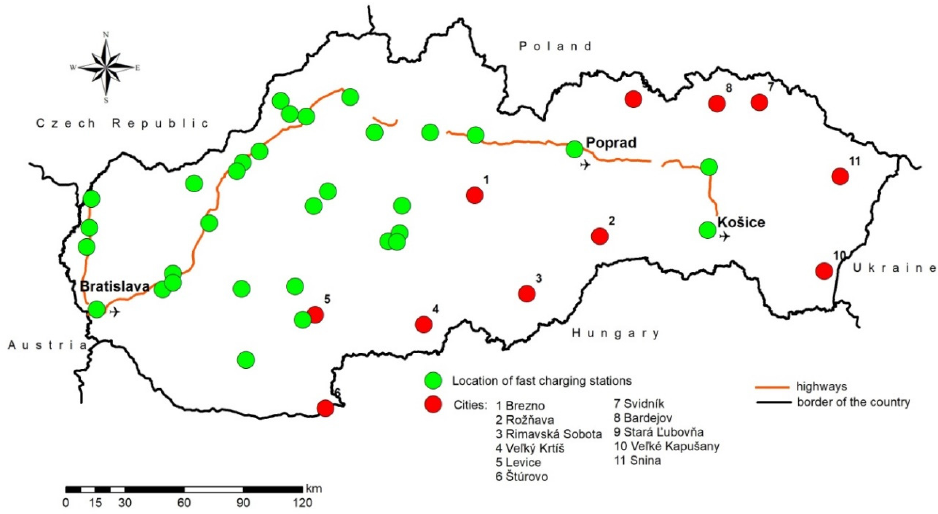
Figure 6. Localization of public fast charging stations in Slovakia in 2018.